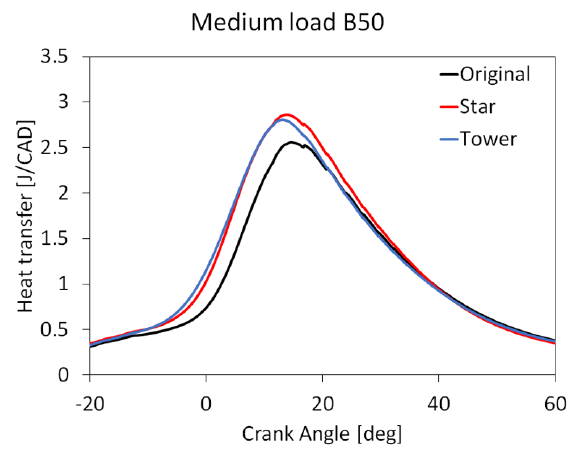
Figure 19. Simulated evolution of heat transfer through the piston for the three different investigated geometries at a medium